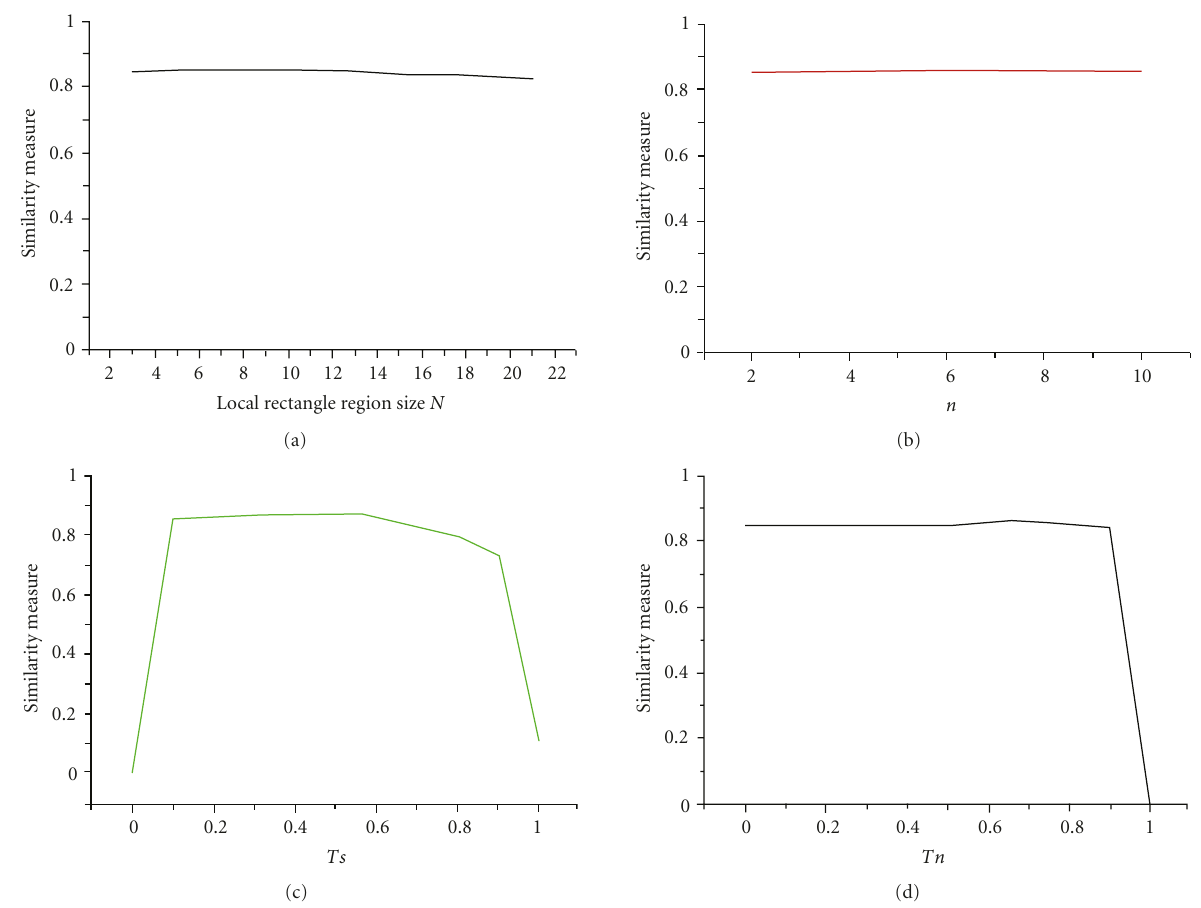
Figure 11: The similarity measures as a function of di ff erent parameter values for the Fountain sequence of Figure 6. While one parameter is varied, other parameters are kept fixed at the values given in Table 1. For each parameter configuration, the final similarity measure is achieved by averaging the similarity measures obtained from all frames.